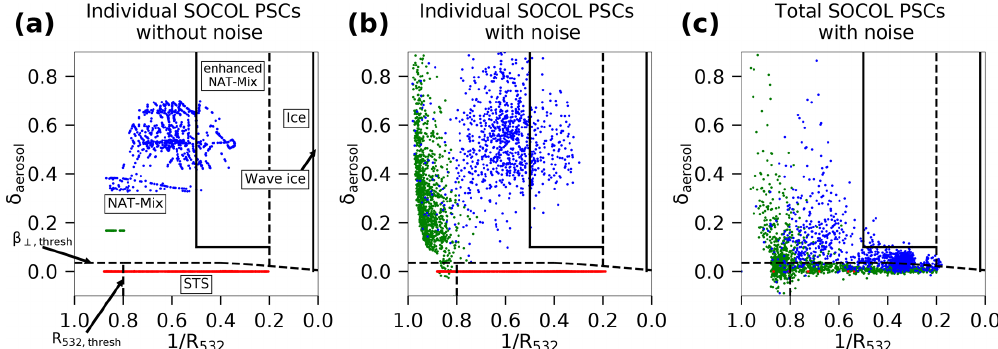
Figure 2. Scatter plot of simulated PSCs from the SOCOL simulation S REF on 1 July 2007 in a 1 /R 532 – δ aerosol coordinate system. (a) STS (red), NAT (green) and ice (blue) as individual components. (b) As in (a) , but after applying observational uncertainties. (c) The modeled PSCs as mixture of all components present per grid box (red: pure STS, green: STS–NAT mixtures, blue: mixtures with ice) with uncertainty.